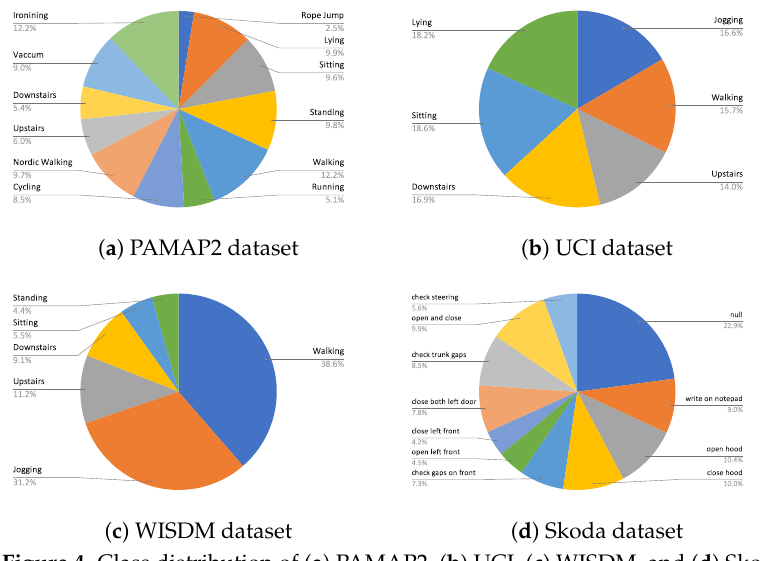
Figure 4. Class distribution of ( a ) PAMAP2, ( b ) UCI, ( c ) WISDM, and ( d ) Skoda